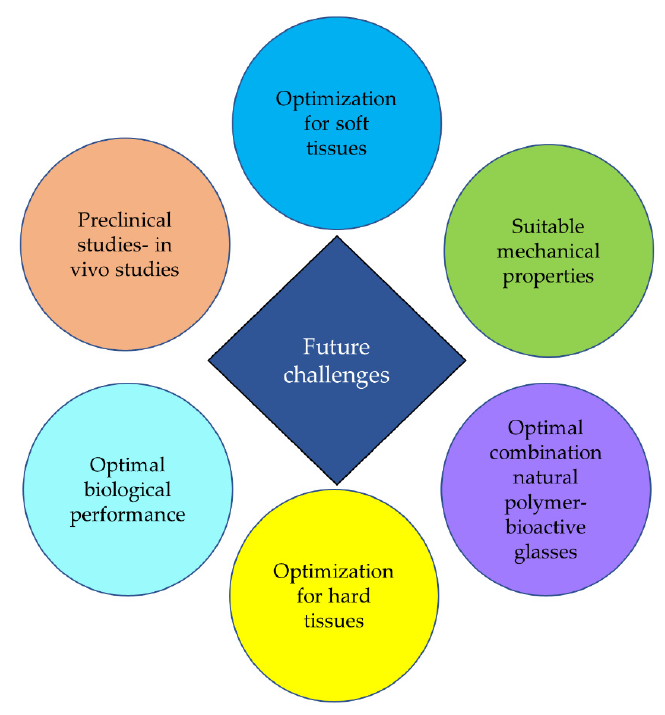
Figure 2. Future challenges.